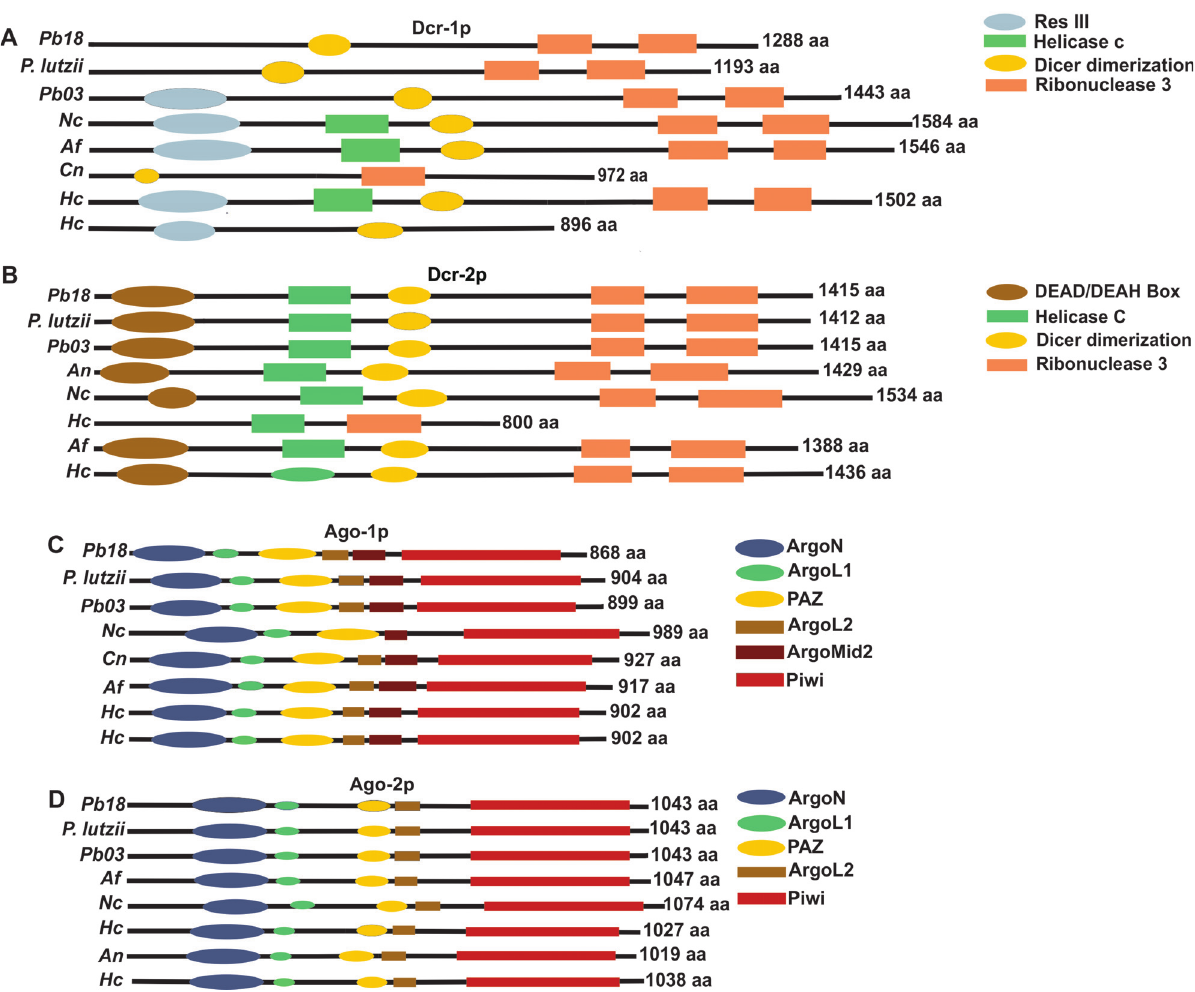
Figure 1 - Domainsidentified in proteinsinvolved in the post-transcriptional gene silencing pathway. (AD)Domainspresent in dicers and argonautspro- teinsfrom P.brasiliensis (Pb18), P.lutzii (Pb01)and P.americana (Pb03).Theaccessionnumbersoftheproteinsareasfollows.Dicer1:(PADG_11946; PABG_04917; PAAG_11489; NCU08270; Afu5g11790; CNAG_02745; HCBG_01751; HCDG_06891), Dicer 2: (PADG_07189; PAAG_00072; PABG_05105; ANID_10380; NCU06766; HCDG_06620; Afu4g02930; HCBG_01136) Ago1: (PADG_00716; PAAG_11422; PABG_02302; NCU09434; CNAG_04609; Afu3g11010; HCBG_06692; HCDG_08528) Ago2: (PADG_03108; PAAG_03231; PABG_00673; Afu8g05280; NCU04730; HCBG_03944; ANID_01519;